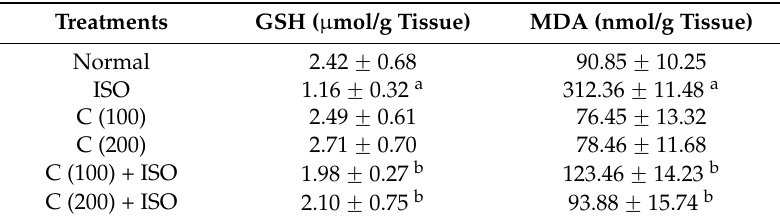
Table 3. Effect of cardamom on glutathione and lipid peroxidation in the isoproterenol-induced myocardial infarction in rats.